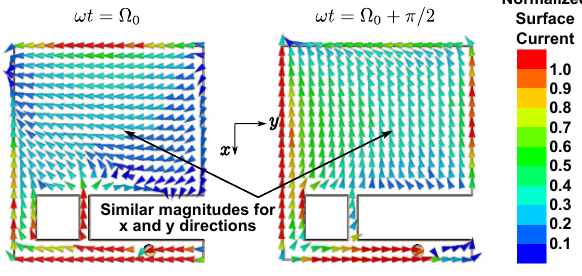
FIGURE 15. Simulated electric surface current vectors on CP Half E-shaped patch for two time instances to demonstrate circular polarization at 2.45 GHz. Adapted from [21].